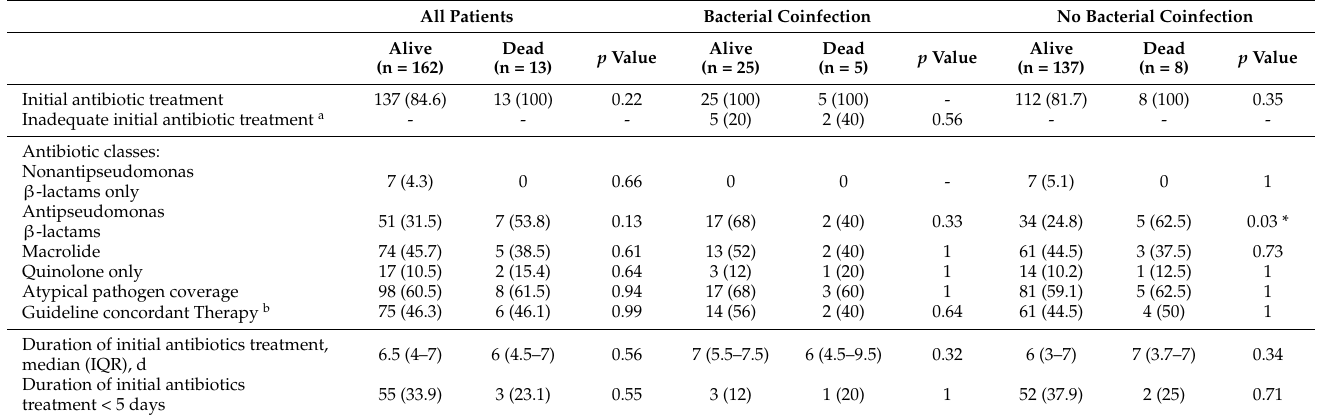
Table 5. Initial antibiotic treatment and mortality within 30 days after admission of all patients hospitalized with respiratory syncytial virus-associated acute respiratory illness. All